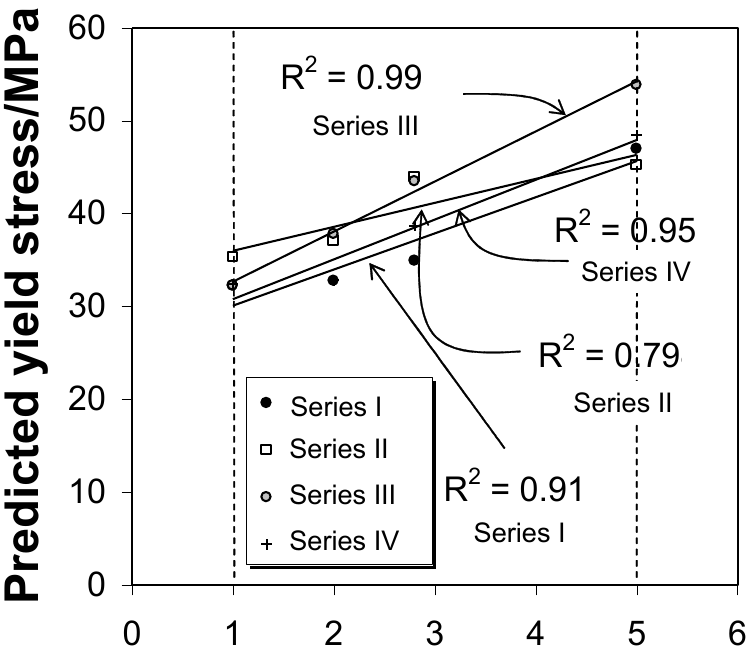
Figure 13. Finite element model predictions of the yield strength plotted as a function of the reinforcement volume fraction for series I-IV steel-LVL composite